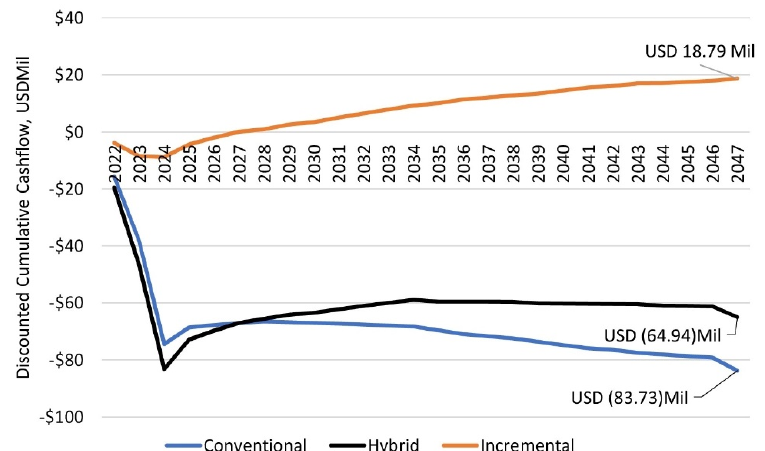
Figure 6. Brownfield-lifecycle cost.